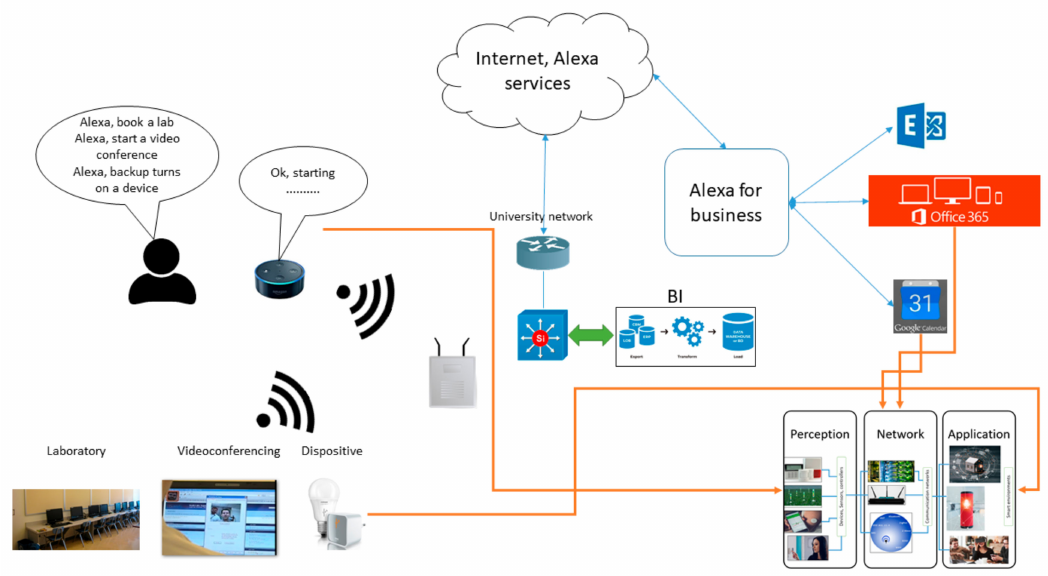
Figure 5. Diagram of an IoT model for space reservation through a voice